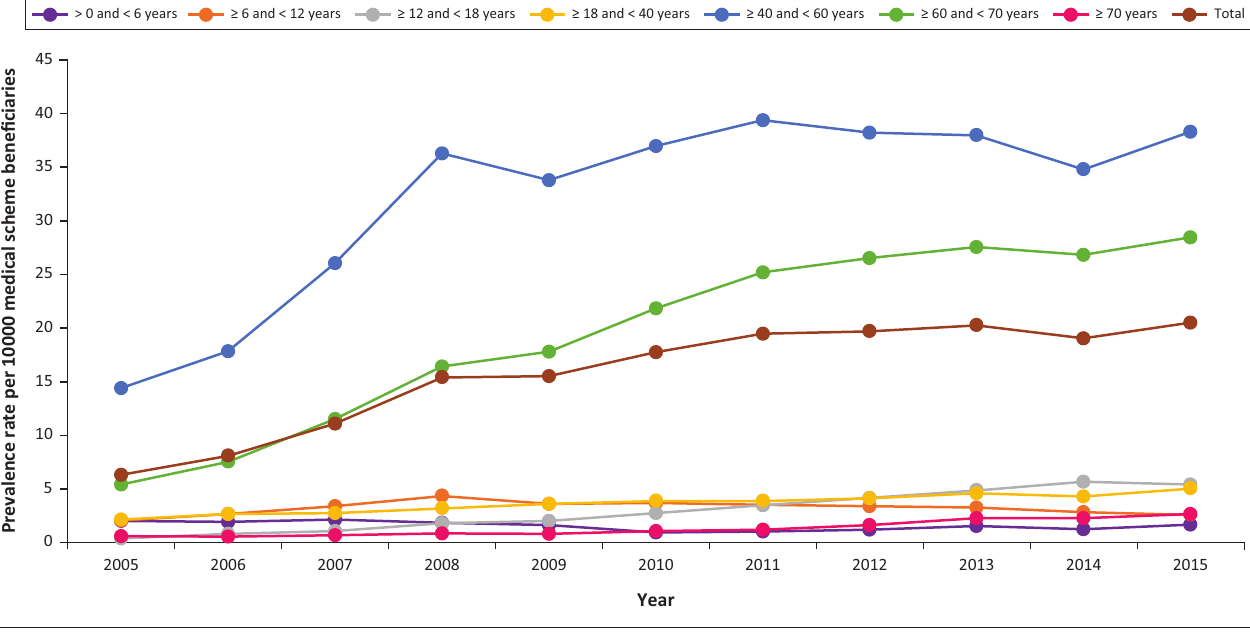
FIGURE 3: Prevalence rate of human immunodeficiency virus or acquired immunodeficiency syndrome patients per 1000 medical scheme beneficiaries as per age groups from 2005 to 2015.